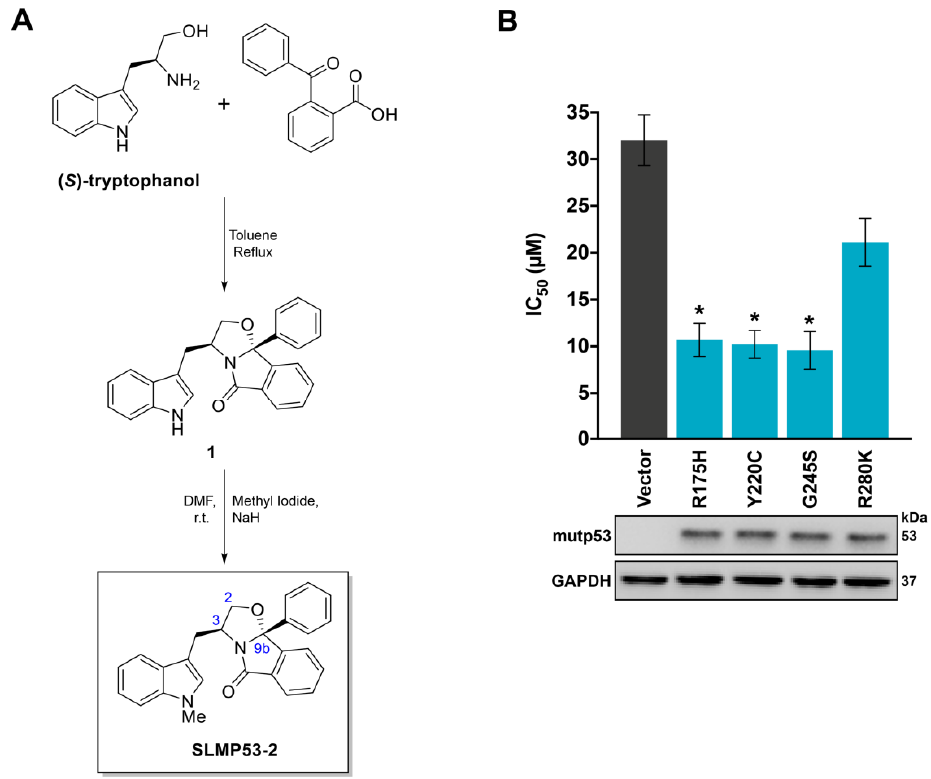
Figure 1. Growth inhibitory effect of SLMP53-2 in human tumor cells is dependent on structural mutp53. ( A ) Chemical synthesis of SLMP53-2. ( B ) IC 50 values of SLMP53-2, in p53-null H1299 cells transfected with pcDNA3 expressing different mutp53 or empty vector, were determined by SRB assay after 48h treatment with 3.12–50 µM SLMP53-2; data are mean ± SEM ( n = 5); values significantly different from pcDNA3-Empty: * p < 0.05, one-way ANOVA with Dunnett’s multiple comparison test. Mutp53 expression was confirmed by western blot; GAPDH was used as a loading control. Immunoblots represent one of three independent